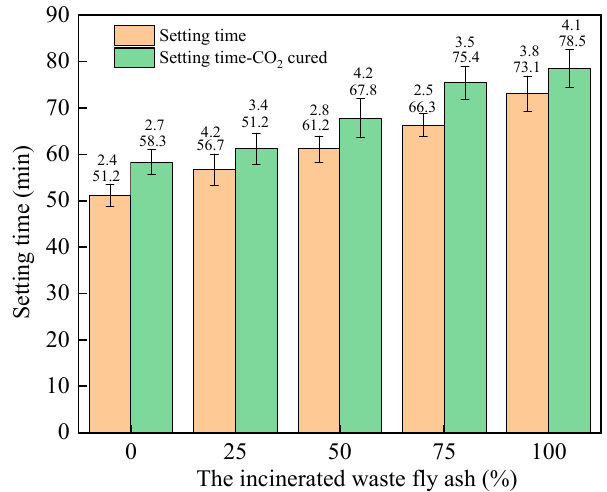
Figure 5. The setting time of the fresh RPC